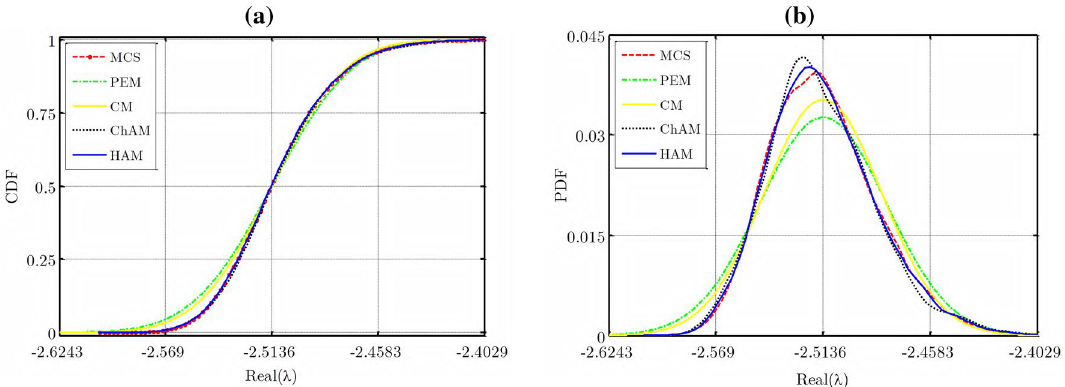
Fig. 5 a Cumulative distribution function, and b Probability distribution function of the real part of the mode#2 eigenvalue of the third gen- erator ( 𝜆 2, G 3 ) , in IEEE 14-bus system